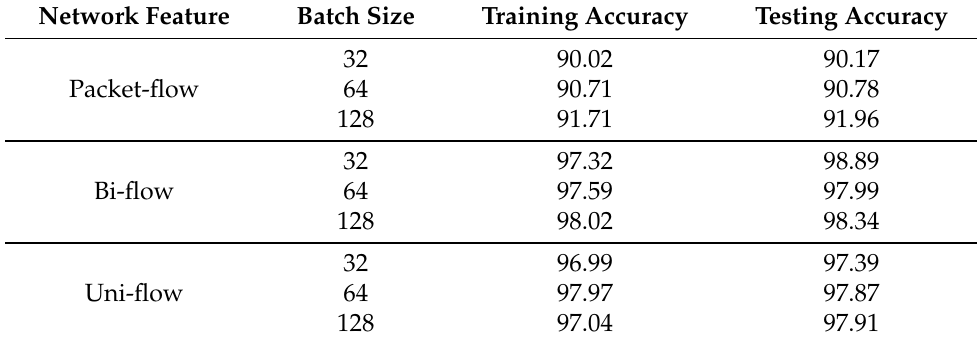
Table 8. Multi-class attacks classification with softmax activation function on output layer.